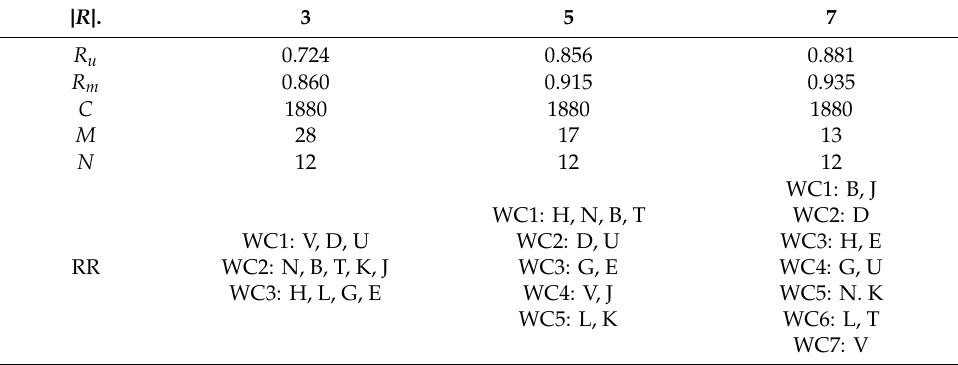
Table 8. Restoration results for di ff erent | R |